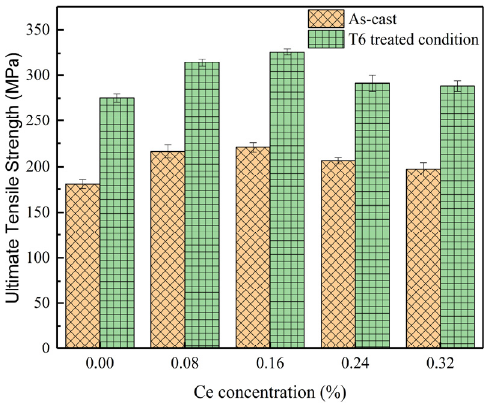
Figure 11. Tensile strength of A357 alloy with different Ce content.